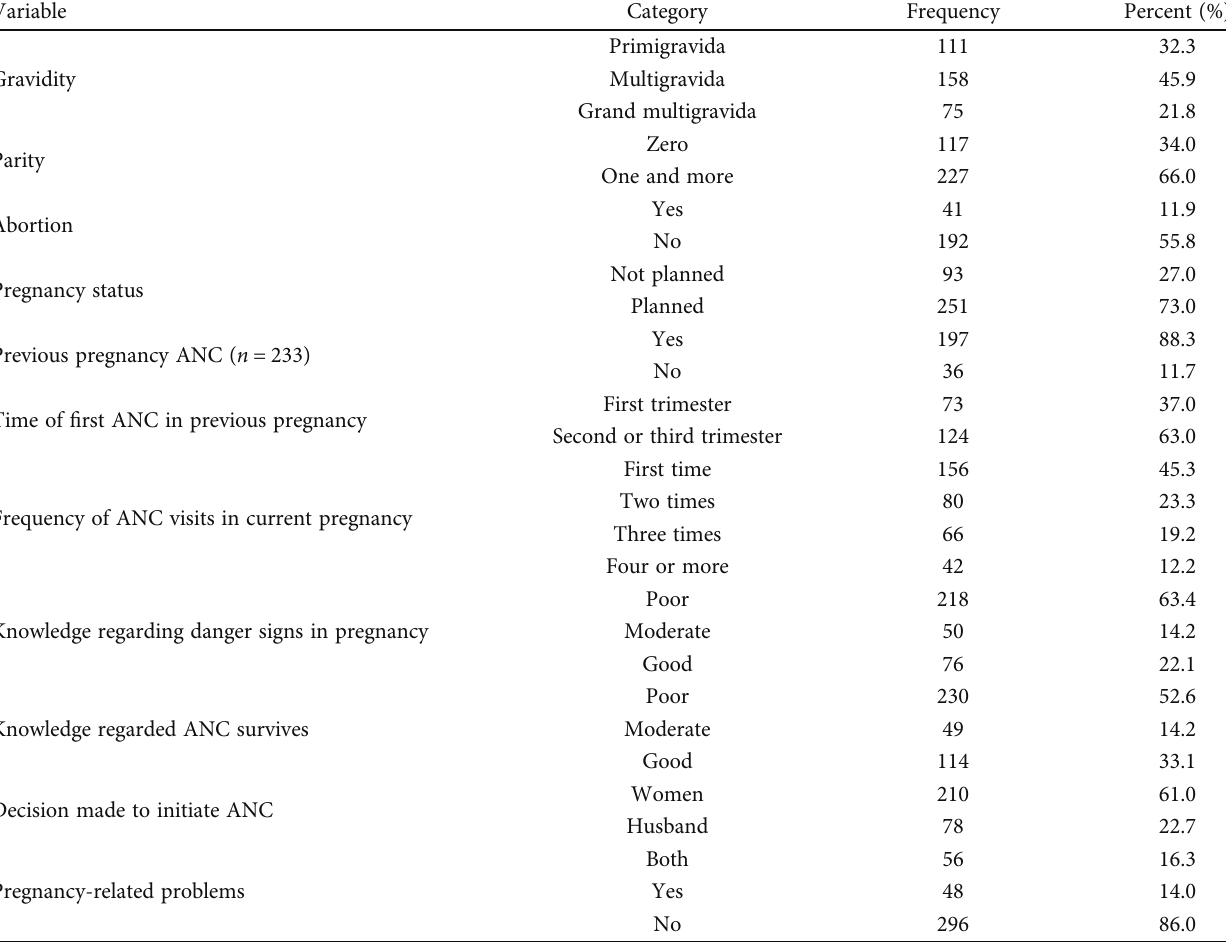
Table 2: Obstetric characteristics of pregnant women attending antenatal care at Wachemo University Nigist Eleni Mohammed memorial comprehensive specialized hospital, Hossana, Ethiopia, 2022.